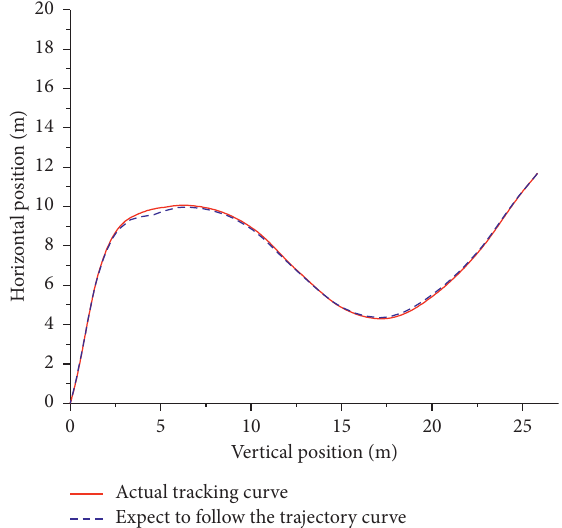
Figure 25: Trajectory position